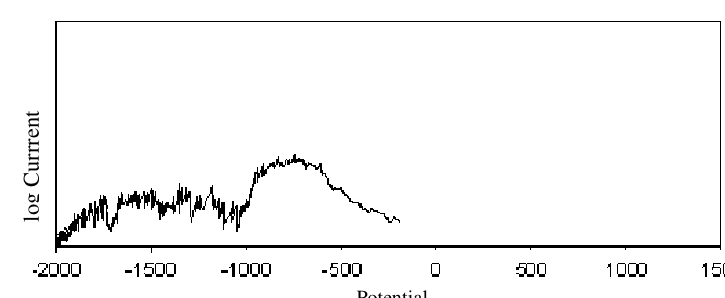
Figure 3 . Electrochemical impedance spectra for Ti in fluoride media at pH 2 +